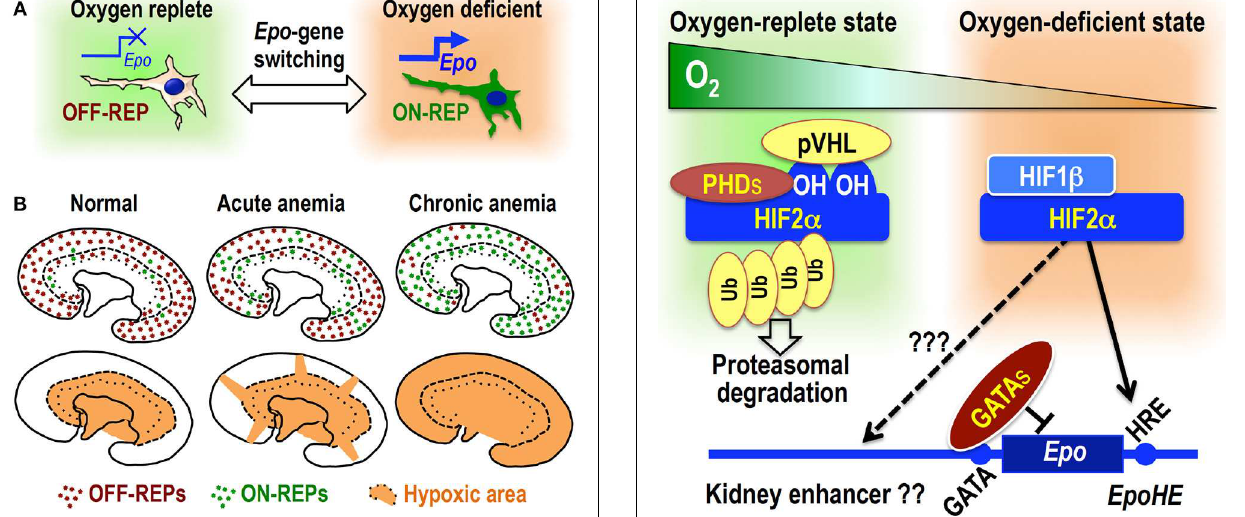
FIGURE 3 | Overview of Epo gene transcriptional regulation. Under oxygen-replete conditions, PHDs hydroxylate HIF2 α proteins, leading to pVHL-mediated ubiquitination and degradation of HIF2 α . Under oxygen-depleted condition, PHDs are inactivated, and HIF2 α escapes degradation. The HIF2 α –HIF1 β heterodimer activates Epo gene transcription by binding to the HRE. The functional HRE for hepatic Epo gene expression ( EpoHE ) is in the proximal downstream region of the transcription end site, whereas a kidney enhancer has been suggested to be located in a region far upstream of the transcription start site. GATA factors constitutively suppress ectopic Epo gene expression in epithelial lineage cells by binding to the promoter GATA